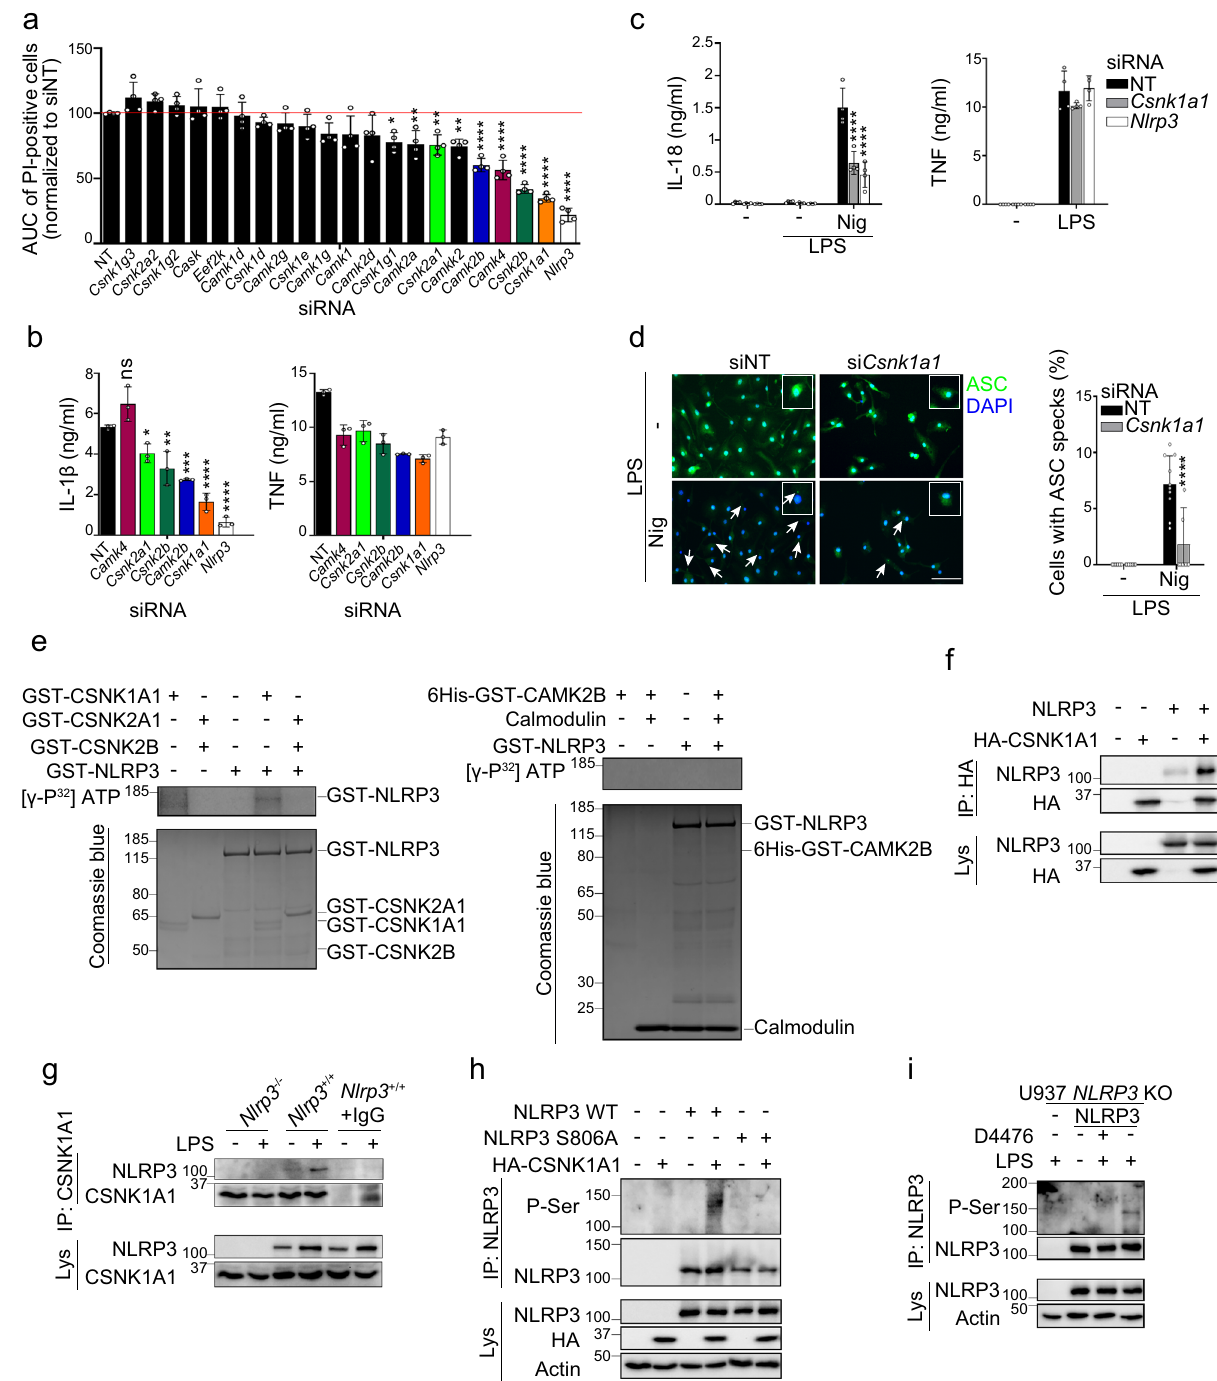
in fl ammasome probably assembles initially, while NLRP3 phos- phosphorylation status as a critical checkpoint of in fl ammasome phorylation by Golgi-associated PKD is later required for activation. in fl ammasome release from the MAMs to the speck. Thus, the S803 is phosphorylated upon priming and dephosphorylated consequences of S291 phosphorylation vary in a timely and upon activation, and both phospho-null S803A and phospho- localized manner, reconciling apparently con fl icting studies 23 – 25 . mimetic S803D/S803E substitutions impair NLRP3 in fl amma- Similarly, both phospho-null and phospho-mimetic mutants of S3 some assembly. These phenotypes are reminiscent of substitutions (in mouse NLRP3, corresponding to S5 in human NLRP3) are of phosphorylated S291 (in mouse NLRP3 corresponding to S295 inhibitory. Indeed S3 phosphorylation by AKT transiently protects in human NLRP3), with both S291A and S291E being inactive 23 . Mechanistical insights revealed that NLRP3 S291 depho- NLRP3 from degradation upon in fl ammasome priming, while it sphorylation is required for NLRP3 initial recruitment in the blocks interaction with ASC upon speck formation 26,27 . Similarly, mitochondria-associated membranes (MAMs) where NLRP3 phosphorylation of S803 must require a timely regulation NATURE COMMUNICATIONS| (2021) 12:5862